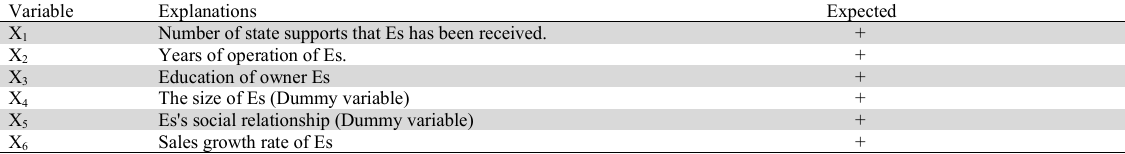
Interpretation of independent variables in a linear regression